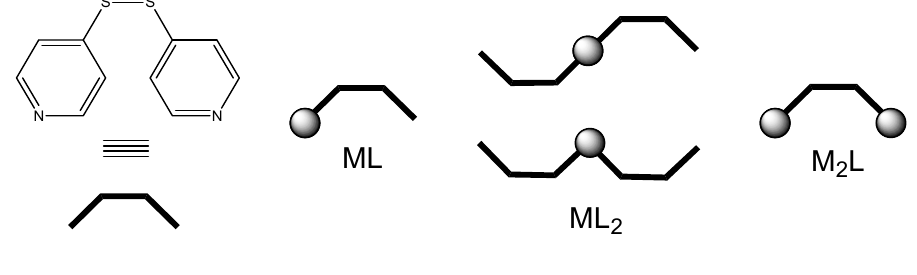
Figure 2. Schematic representation of molecular dtdp complexes. Large grey spheres represent metal